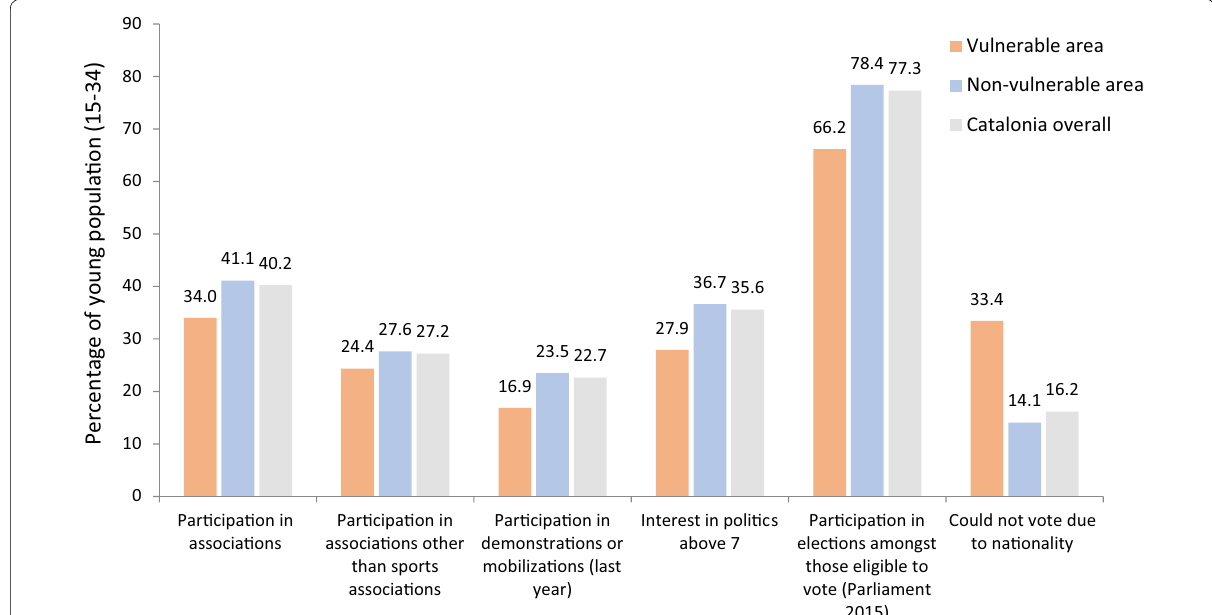
Fig. 1 Participation in associations and elections and interest in politics of the young population in Catalonia according to the level of urban segregation (2017) (Source: Own elaboration from the data provided by the Enquesta de Joventut de Catalunya,